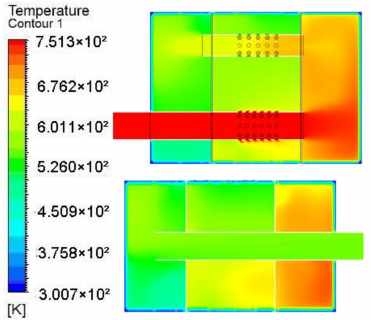
Figure 9. Contour of temperature in the cross section of the silencer.